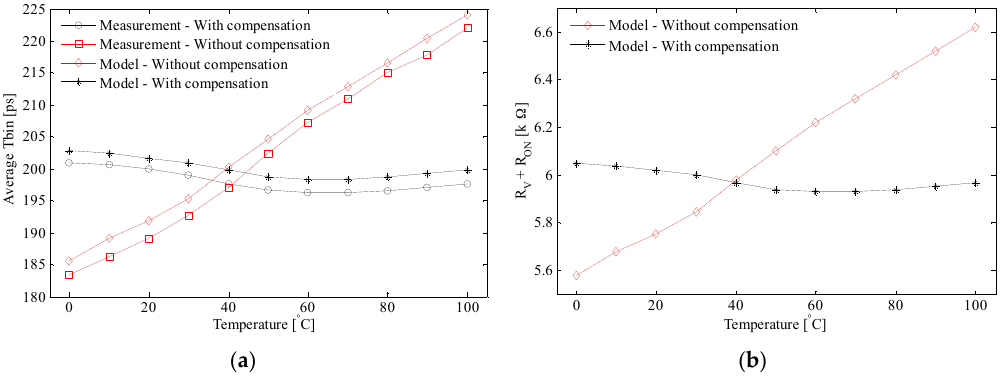
Figure 8. ( a ) Average T bin dependence on temperature variation: with compensation (model—asterisk marker; measurement—circle marker) and without compensation (model—diamond marker; measurement—square marker) ( b ) Equivalent resistance R V + R ON as a function of temperature: with compensation—asterisk marker; without compensation—diamond marker.